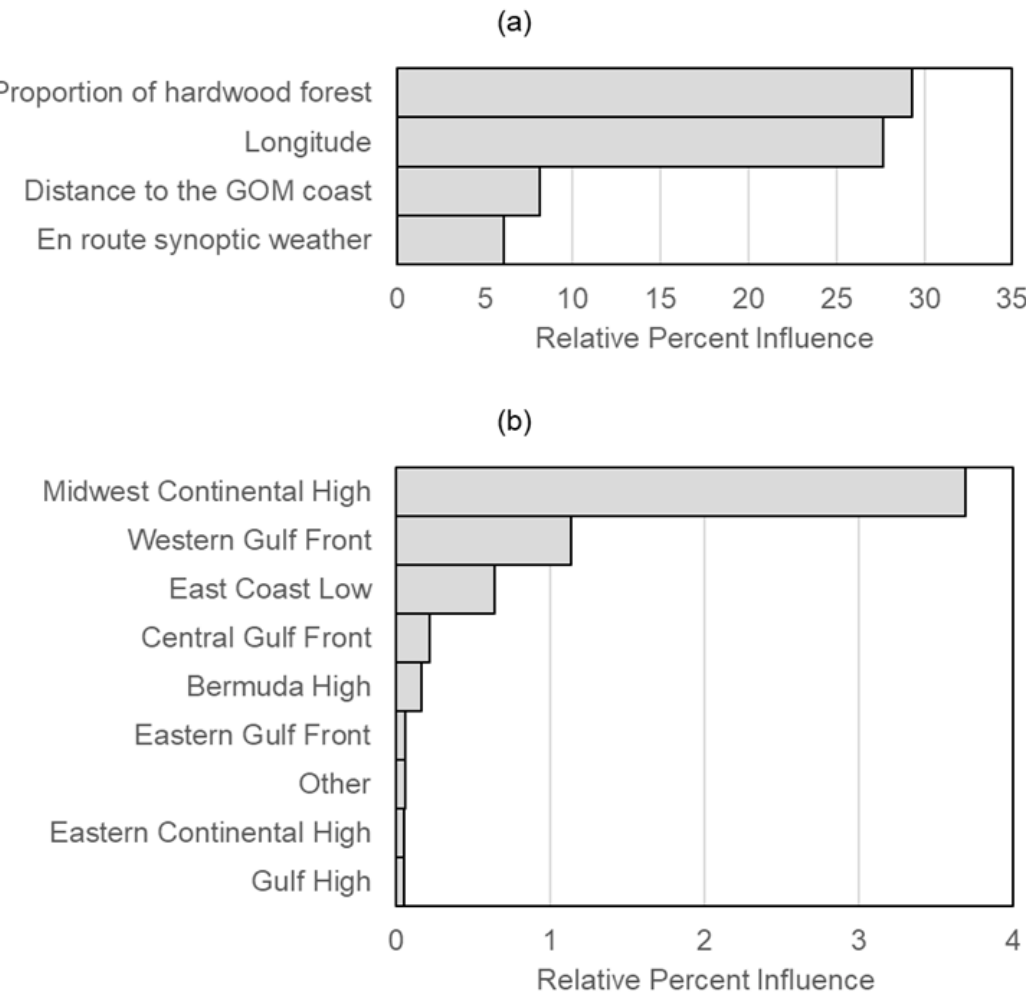
Figure 4. Relative influence of ( a ) en route synoptic weather (i.e., encountered during migration over the Gulf of Mexico [GOM]) summed across weather types compared to other ecological predictor variables (i.e., excluding distance from the radar and relative elevation) and ( b ) individual en route synoptic weather types on bird stopover density from the boosted regression tree model (percent deviance explained = 63.2%, CV correlation = 0.655). Other predictor variables pertained to geography (longitude, distance from the GOM coast) and landscape (proportion of hardwood forest within 5 km). CV correlation is the mean correlation of predictions using cross-validated (i.e., out-of-bag) data. 306 3.3. Influence of favorable vs. unfavorable synoptic weather types on stopover distributions 307